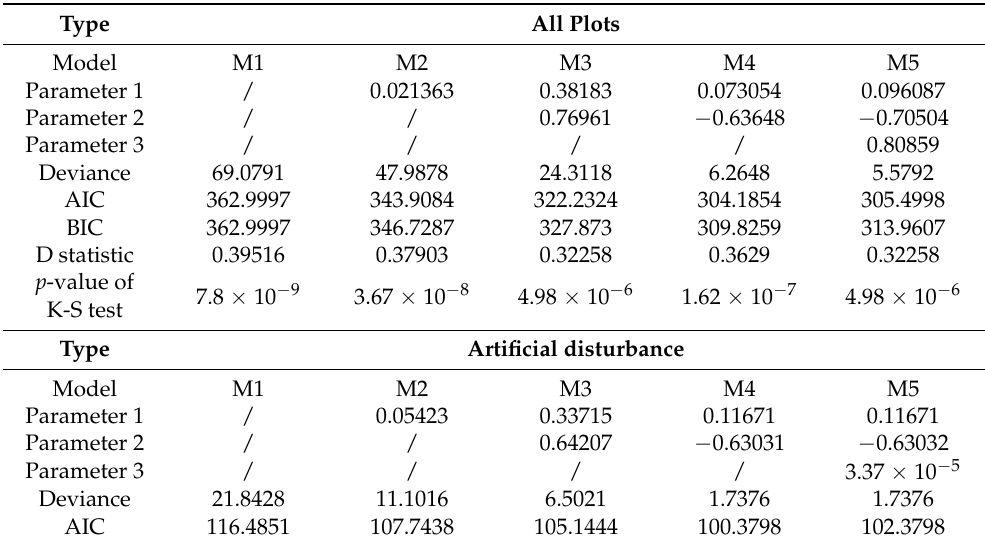
Figure 2. Comparison of diversity indices between the natural and artificial disturbance community (numbers above the bars indicate p -value). Table 2. Fitting results of five SAD models.